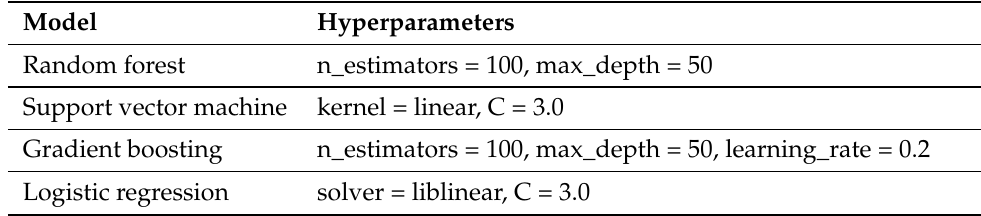
Table 4. Hyperparameters and associate values used for